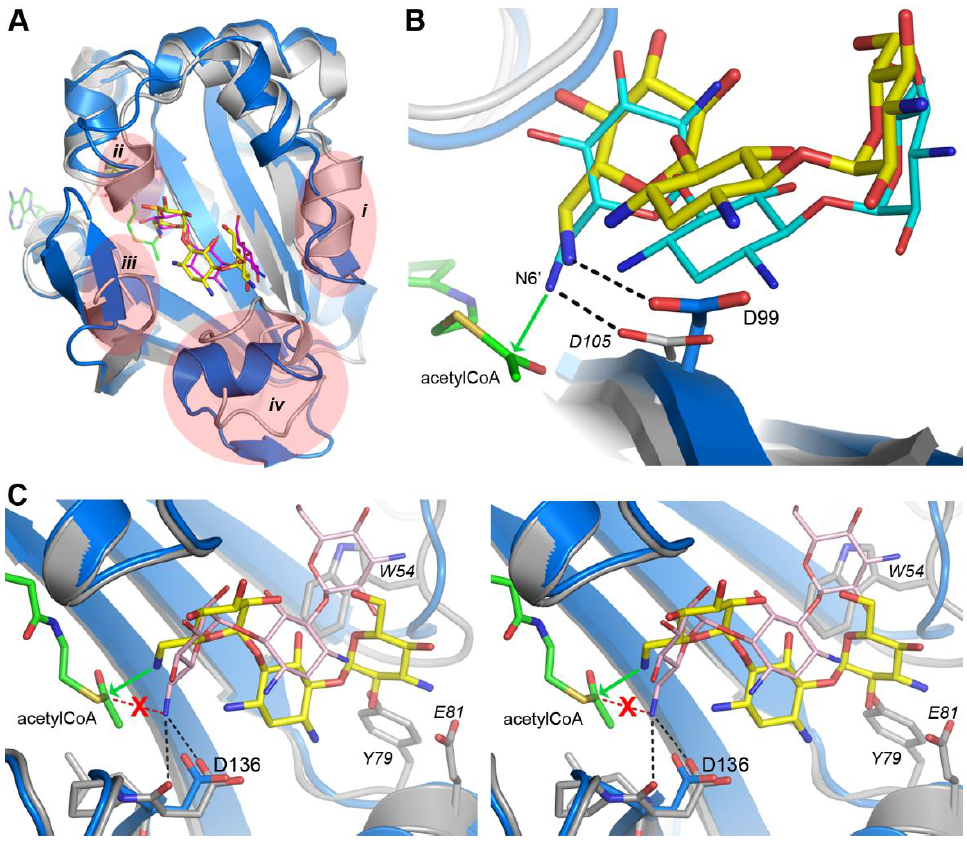
FIGURE 5: Structural comparison of AAC(6’)-Im and AAC(6’)-Ib. (A) Superposition of AAC(6’)-Im (blue) and AAC(6’)-Ib (grey). Kanamycin A is shown in yellow sticks for AAC(6’)-Im and kanamycin C in magenta sticks for AAC(6’)-Ib. The acetyl-CoA cofactor present in AAC(6’)-Ib is shown as green sticks. The four main regions of structural difference near the substrate binding site are indicated in pale red, as described in Figure S4A. (B) Close up view of superimposed kanamycin A substrates in AAC(6’)-Im (yellow with the enzyme shown in blue) and AAC(6’)-Ib (cyan with the enzyme shown in grey). In AAC(6’)-Ib the N6’ group is positioned by a hydrogen bond to the Asp105 side chain (labeled in italics), and the favorable close approach of the N6’ to the acetyl carbon is shown by the green arrow. A similar hydrogen bonding interac- tion is seen in AAC(6’)-Im with the Asp99 side chain. (C) Stereoview close up of the active site in AAC(6’)-Ie (grey) superimposed onto AAC(6’)-Im (blue). The kanamycin A substrates in AAC(6’)-Im (yellow) and AAC(6’)-Ie (pink) are shown. The difference in orientation of the two aminoglycosides directs the N6’ group in AAC(6’)-Ie away from the acetyl-CoA, where it is anchored by two hydrogen bonds to Asp136. The favorable approach of the N6’ group to the acetyl carbon in the AAC(6’)-Im-bound kanamycin A is indicated by the green arrow, and what would be a unfavored orientation in AAC(6’)-Ie is indicated by a red dashed line. Residues from AAC(6”)-Ie are labeled in